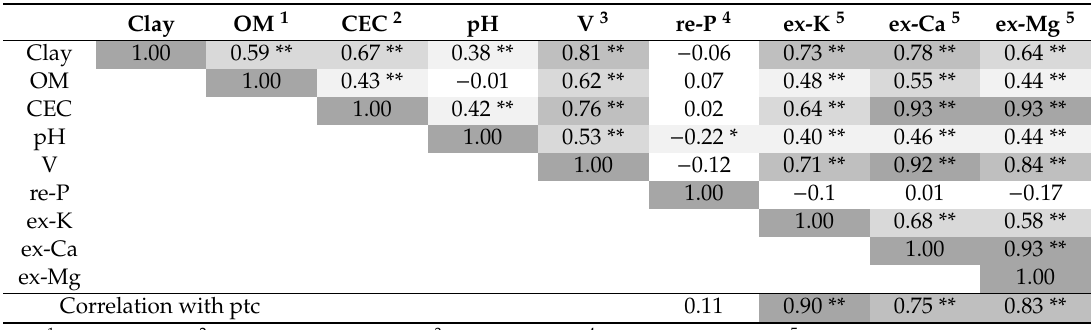
1 Organic matter, 2 cation exchange capacity, 3 base saturation, 4 resin-extracted P, and 5 exchangeable (ex-)